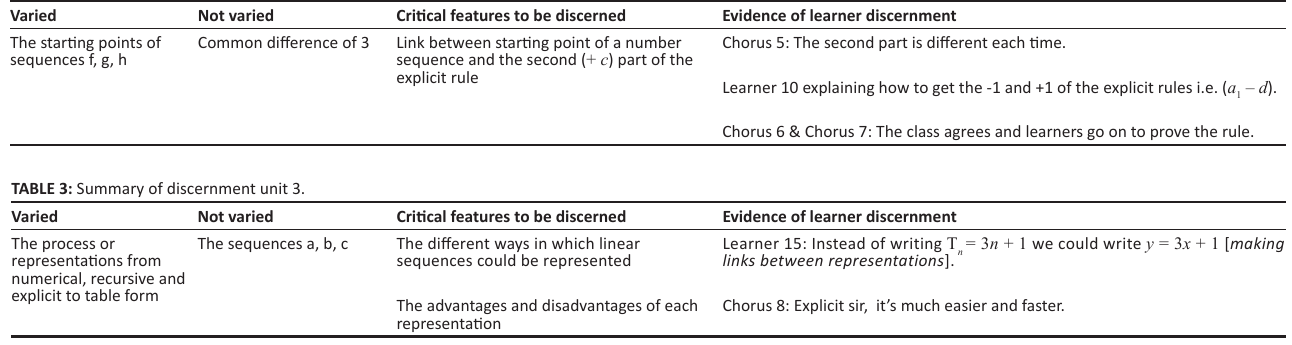
TABLE 2: Summary of discernment unit 2. Varied Not varied Critical features to be discerned Evidence of learner discernment The starting points of Common difference of 3 sequences f, g, h